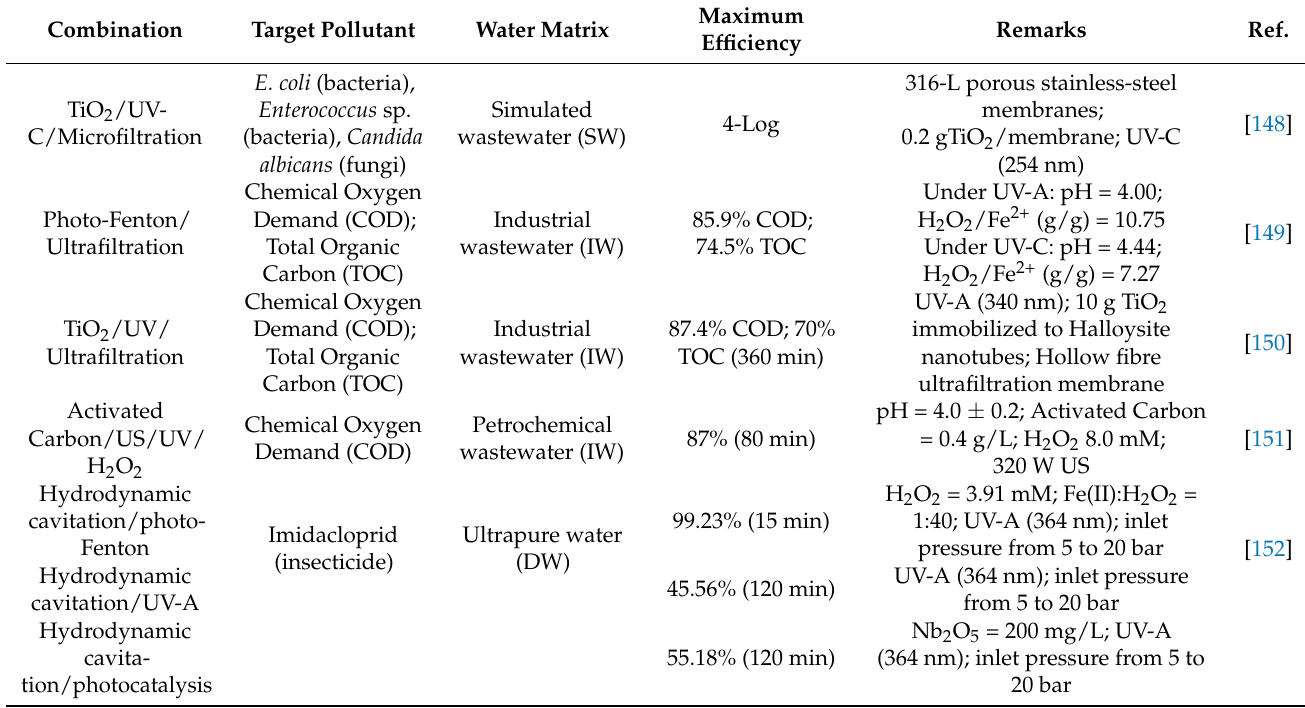
Table 11. Hybrid or single-step combination photo-assisted advanced oxidation processes with other